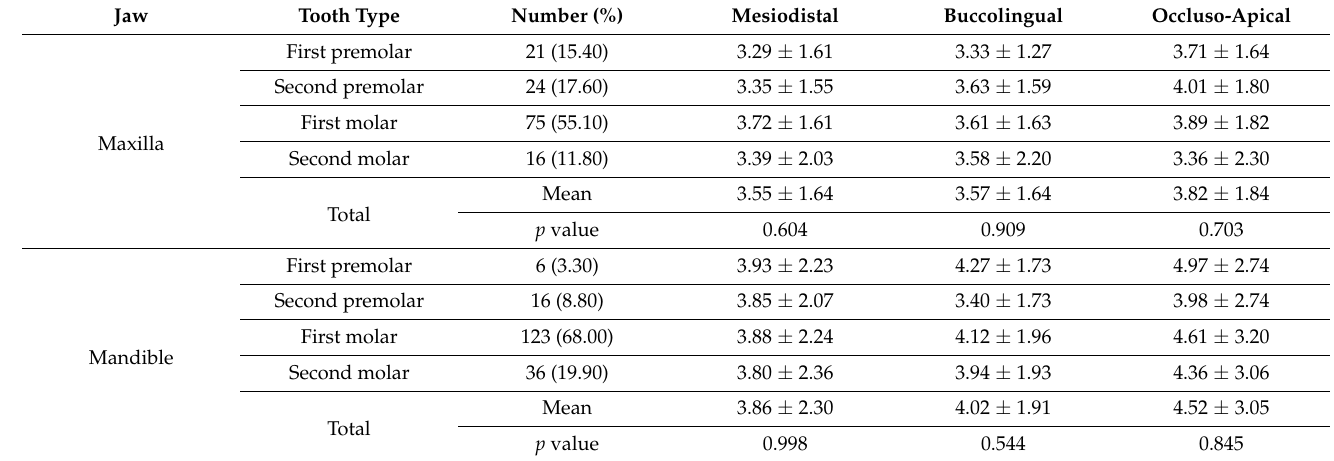
Table 5. Mean size of lesions in the three dimensions based on tooth